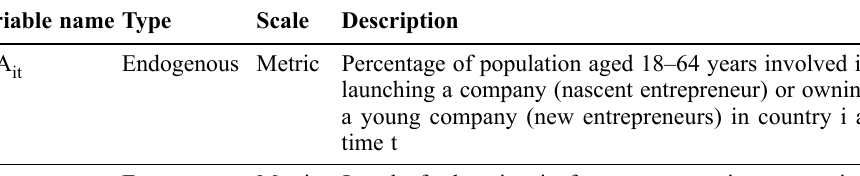
Table 1. Variables included in the general